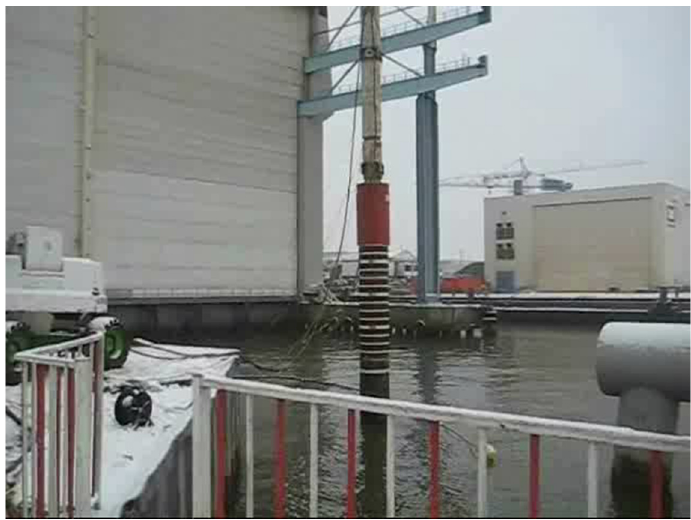
Figure 1. The test pile of IHC Hydrohammer B.V. at Kinderdijk, near Rotterdam, The Netherlands. Hydrophones and geophones were deployed, connected to recording equipment on the quayside.